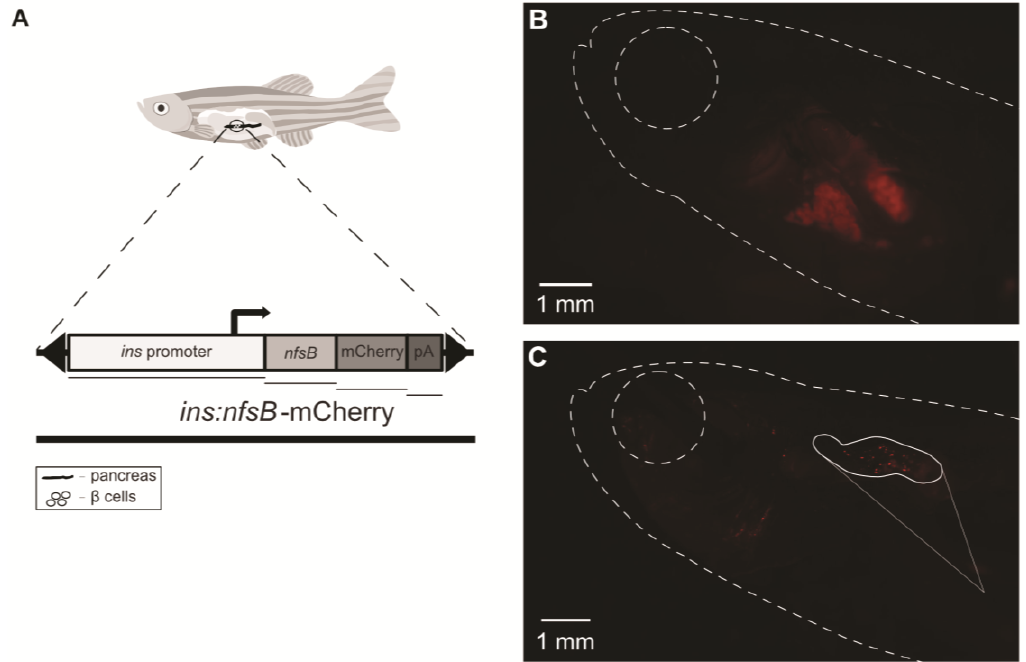
Figure 1. Confirmation of pancreatic β-cell ablation and onset of diabetes in zebrafish males. ( A ) Graphic representation of the construct inserted in the Tg( ins : nfsb-mCherry ) genome. ( B ) Observation of pancreas with lack of fluorescence in Tg( ins : nfsb-mCherry ) diabetic males, with evident pancreatic β-cell ablation and onset of diabetes. ( C ) Observation of pancreatic fluorescence in Tg( ins : nfsb-mCherry ) control males after dissection, with the presence of live β cells (white area showing magnification of the pancreas).